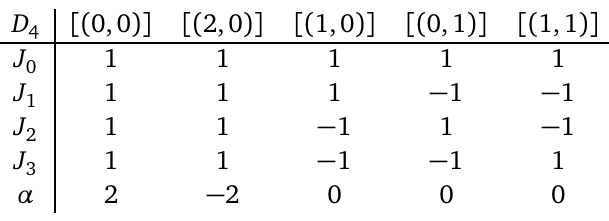
Table 2: The character table of D